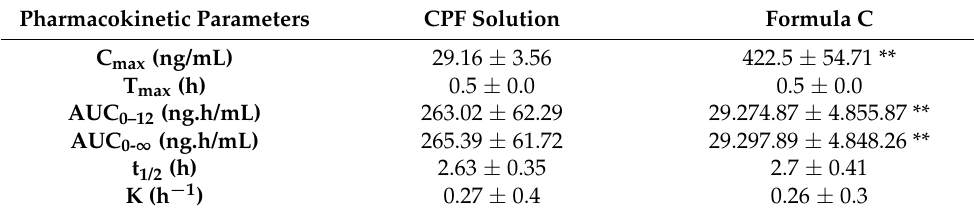
Table 3. Pharmacokinetic parameters following intranasal administration of CPF and formula C of CPF.